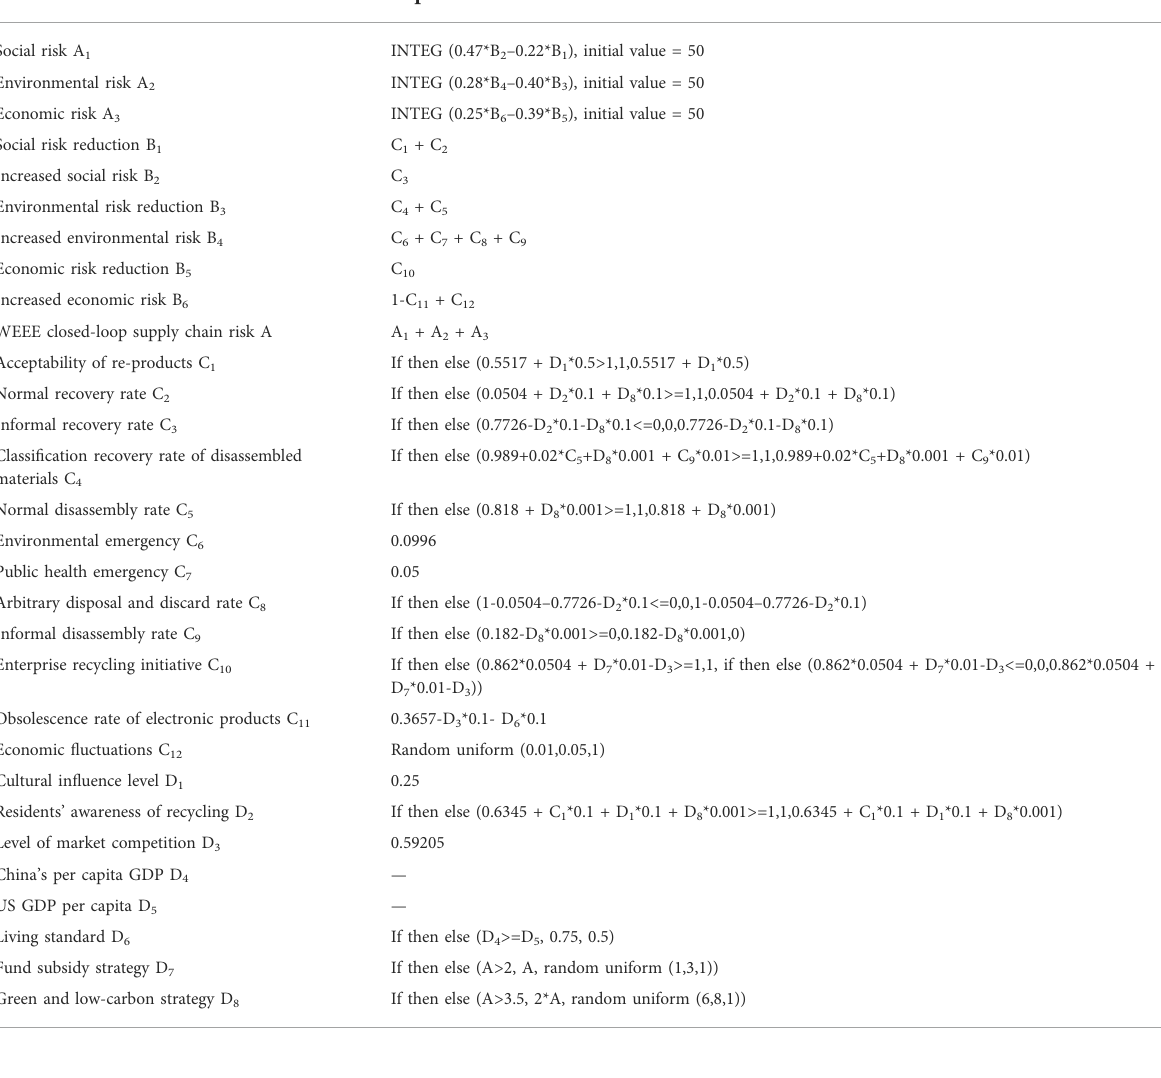
TABLE 4 Expression and data source table.